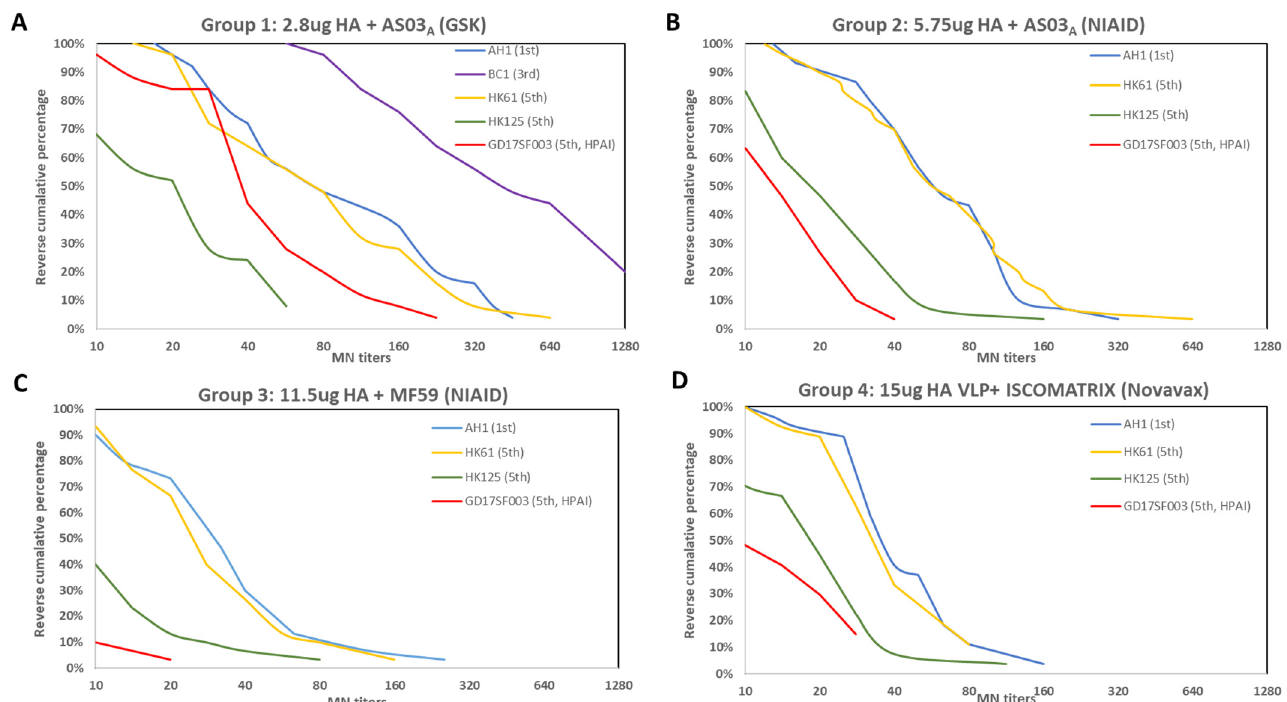
Figure 1. Reverse cumulative percentages of MN antibody responses to homologous and heterolo- gous A(H7N9) viruses following A(H7N9) vaccination from 4 vaccine groups. Time points shown are 21–28 days post-2nd dose. ( A ) Vaccine group 1 received inactivated vaccines formulated at 2.8 µ g HA/dose with AS03 A adjuvant from the GSK trial; ( B ) Vaccine group 2 received inactivated vaccine formulated at 5.75 µ g HA/dose adjuvanted with AS03 A from the NIAID sponsored trial; ( C ) vaccine group 3 received inactivated vaccine formulated with 11.5 µ g HA/dose adjuvanted with MF59